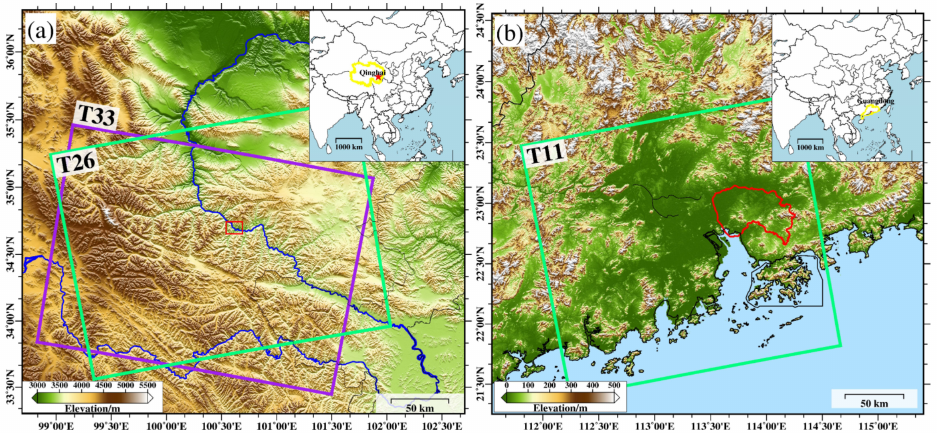
Figure 6. Location of the two study areas in China and the spatial coverage of the images used in the study. Insets show the location of ( a ) Lajia Town of Qinghai Province and ( b ) Dongguan city of Guangdong Province in China. Background is the Shuttle Radar Topography Mission (SRTM) digital elevation model (DEM) with a resolution of 90